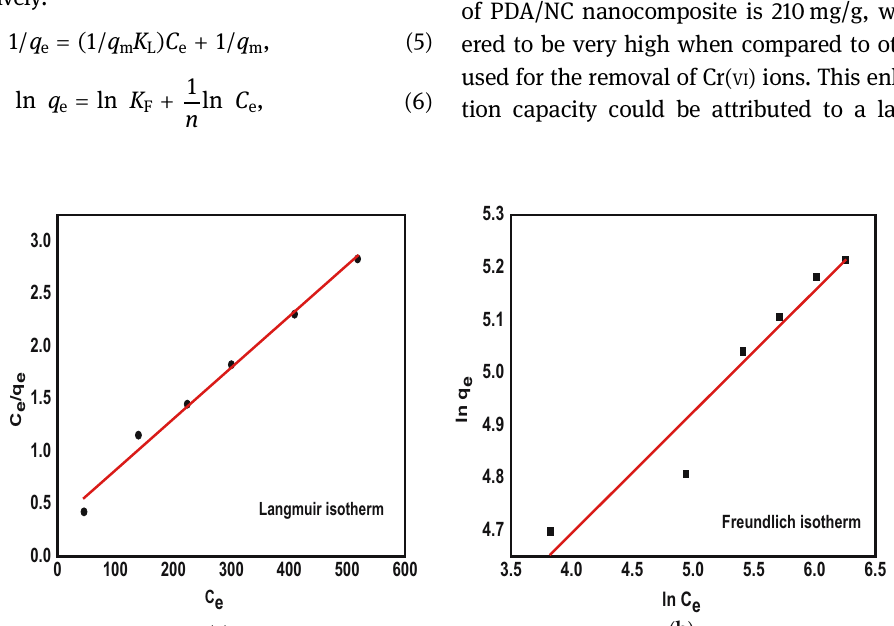
Figure 6: The fi tting of experimental data to Langmuir isotherm ( a ) and Freundlich isotherm ( b ) for the adsorption of Cr ( VI ) ions on the surface of PDA/NC